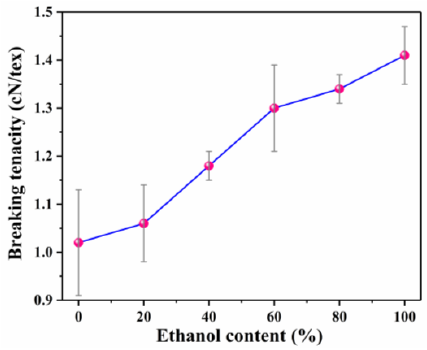
Figure 15. Effects of ethanol content in oxidative bleaching solution on breaking tenacity of camel hair.